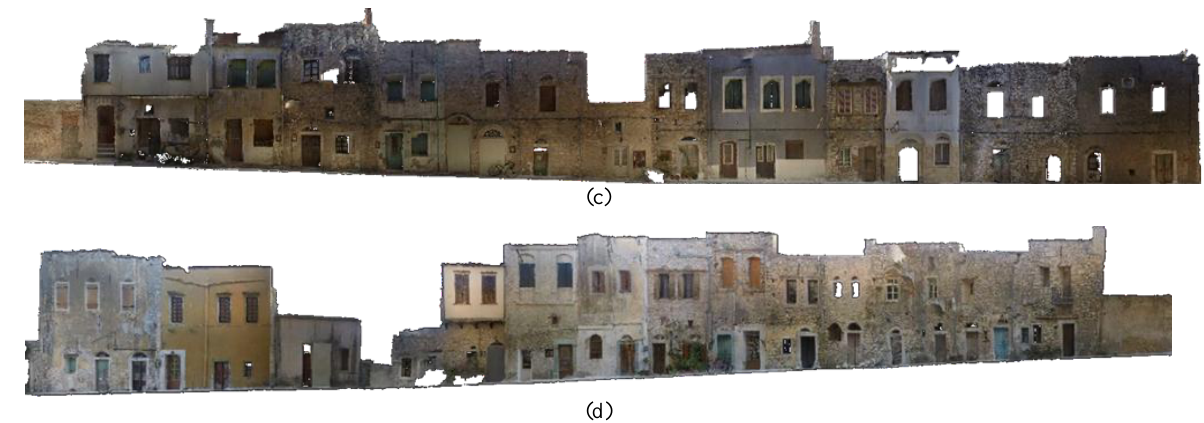
Figure 11: Orthoimages of Area 1 (a and b) and Area 2 (c and